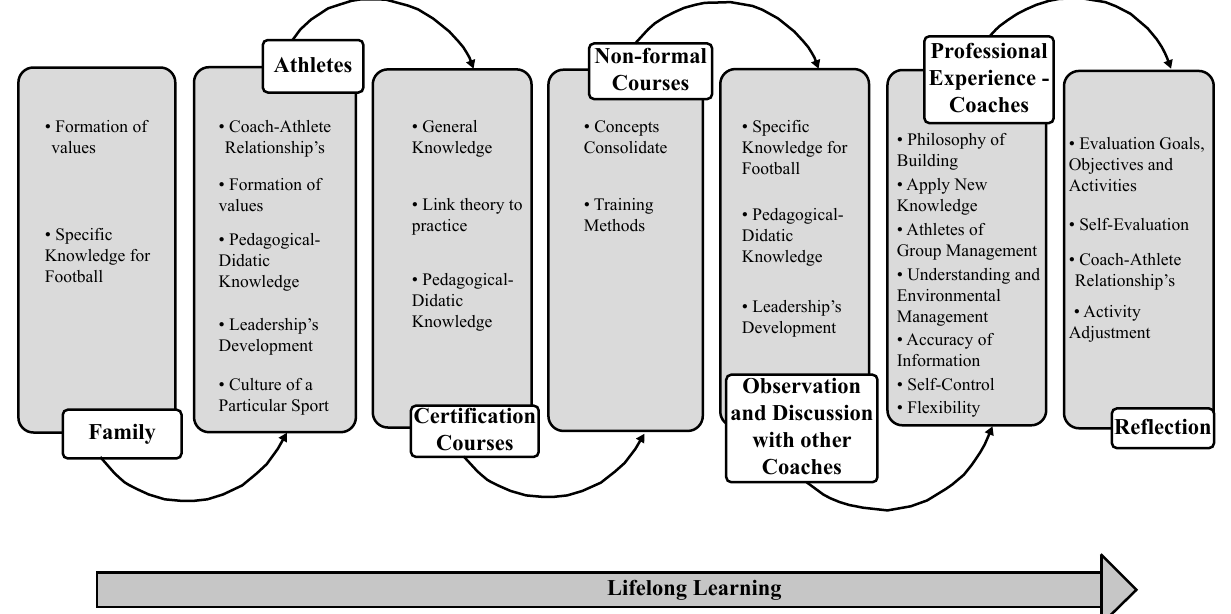
Figure 3 Episodes and content learning presented lifelong of sports